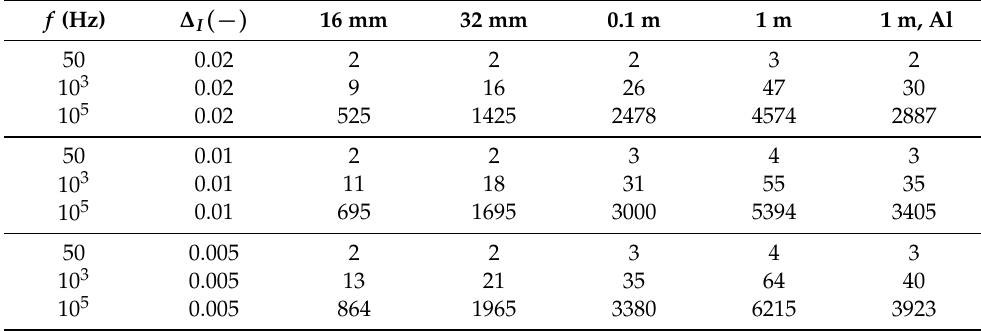
Table 2. Example 3, α = 0: The dependences of time t sin (expressed by the number of whole periods T and rounded up) on f , ∆ I and d .